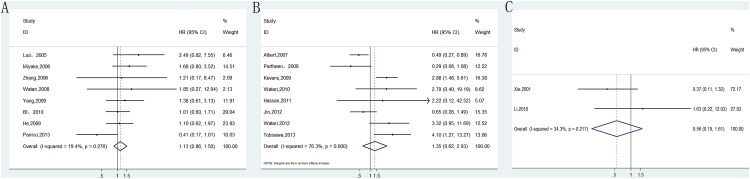
Forest plots of merged analyses of overall survival (OS) in association with sCLU expression in different groups.Forest plots of merged analyses of disease-free survival (DFS)/relapse-free survival (RFS). Squares and horizontal lines represent study-specific HRs and 95% CIs, respectively. The areas of the squares correspond to weights, and the diamonds represent overall HRs and 95% CIs. (A) Forest plots of merged analyses of overall survival (OS) in group 1. (B) Forest plots of merged analyses of overall survival (OS) in group 2. (C) Forest plots of merged analyses of overall survival (OS) in group3.